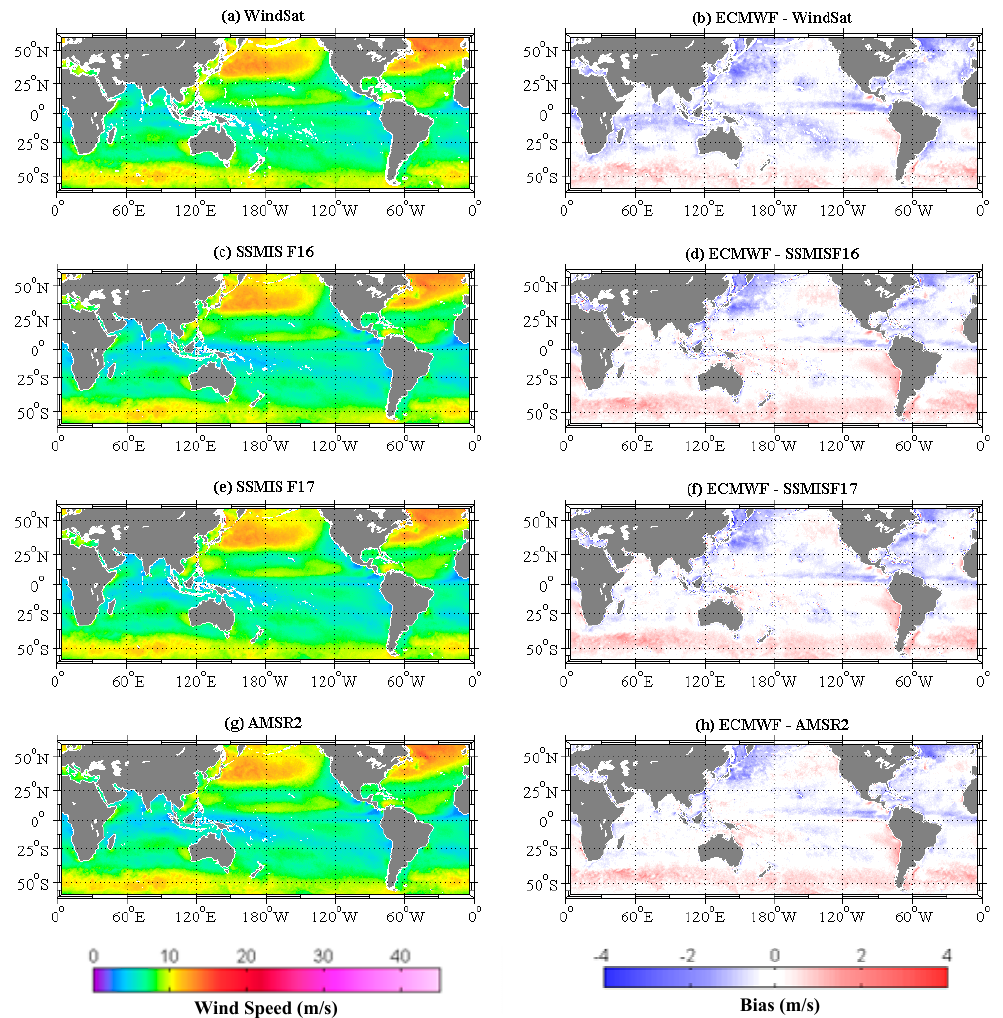
Figure 8. Maps of mean monthly (in January) wind speeds derived from four different satellites during the period from 2013 to 2017: ( a ) WindSat; ( c ) SSMIS F16; ( e ) SSMIS F17; and ( g ) AMSR2. The corresponding wind speed differences between each satellite and ECMWF: ( b ) ECMWF–WindSat; ( d ) ECMWF–SSMIS F16; ( f ) ECMWF–SSMIS F17; and ( h ) ECMWF–AMSR2.